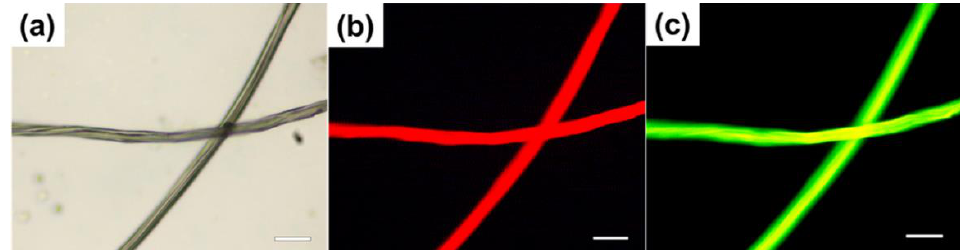
Figure 12. ( a ) Bright-field image of cotton fibers stained with BNQDs. ( b ) Fluorescence image of cotton fibers stained with BNQDs obtained at the excitation wavelengths of 510–550 nm. ( c ) Fluorescence image of cotton fibers stained with BNQDs obtained at the excitation wavelengths of 450–480 nm. Scale bar: 50 µ m. Reproduced from [70] with permission from copyright © 2017 American Chemical Society.